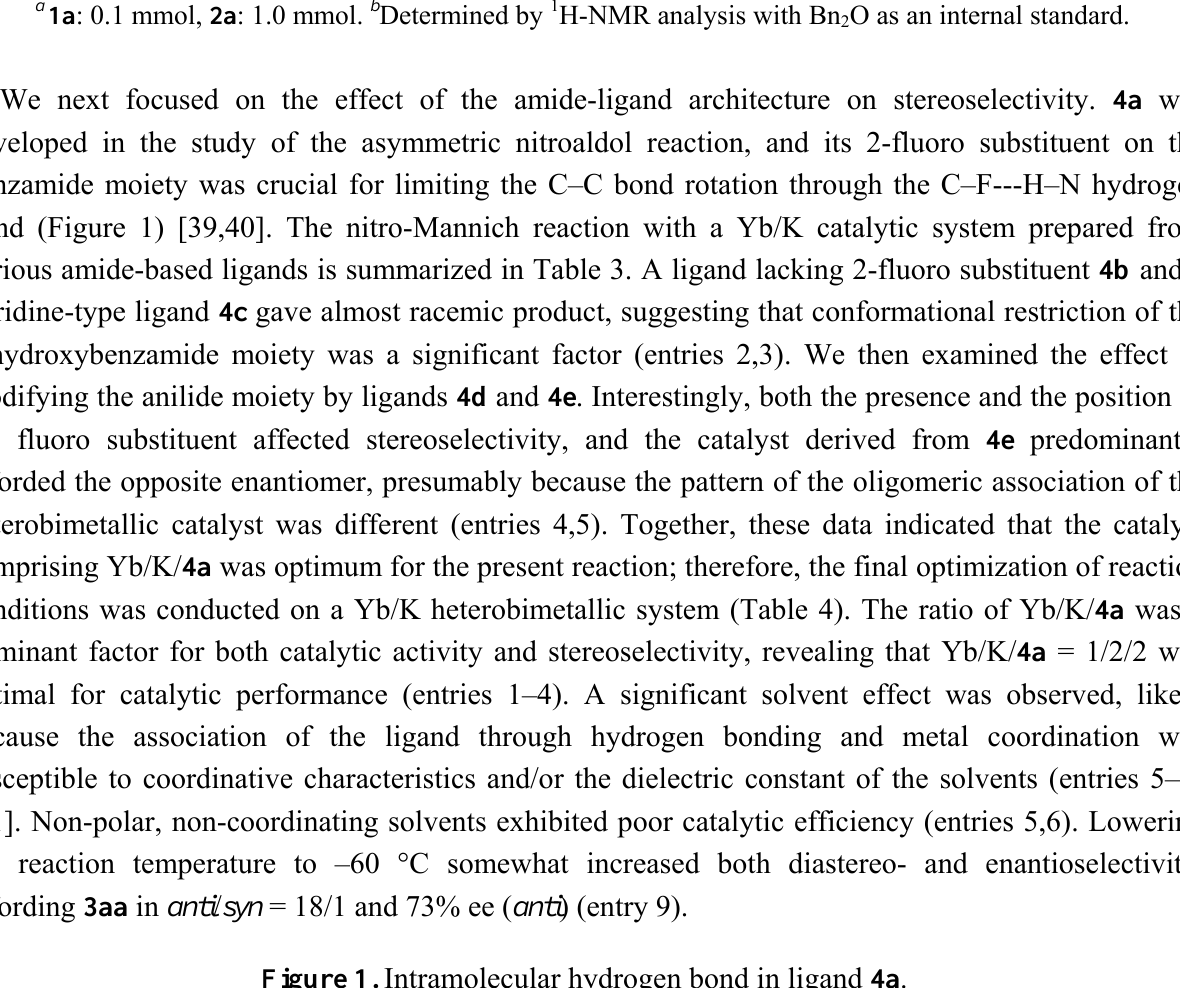
Figure 1. Intramolecular hydrogen bond in ligand 4a